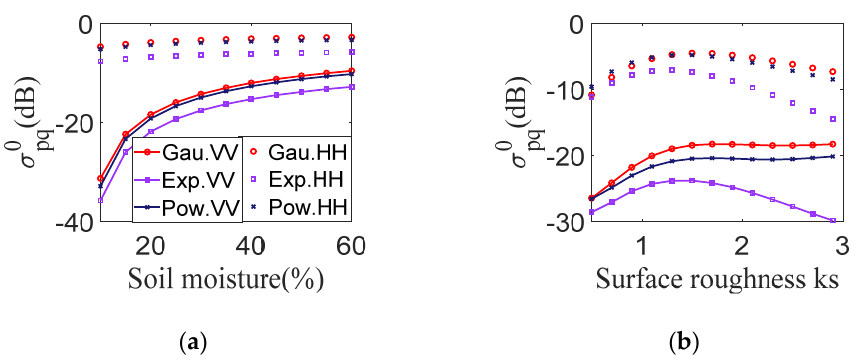
Figure 5. Variations in bistatic scattering coefficients with ( a ) soil moisture and ( b ) surface roughness.